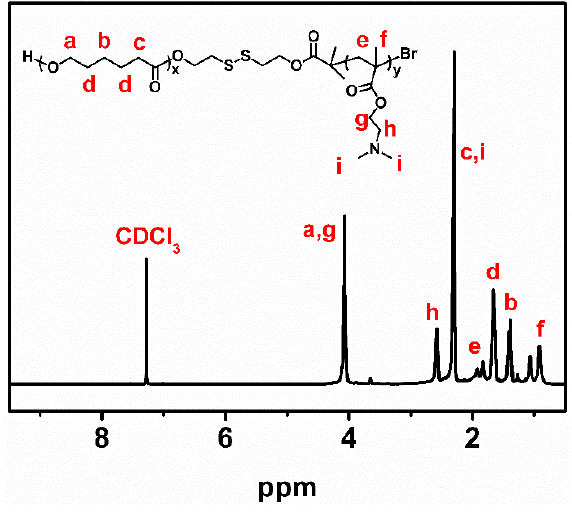
Figure 2. 1 H NMR spectra of PCL-SS-PDMAEMA.